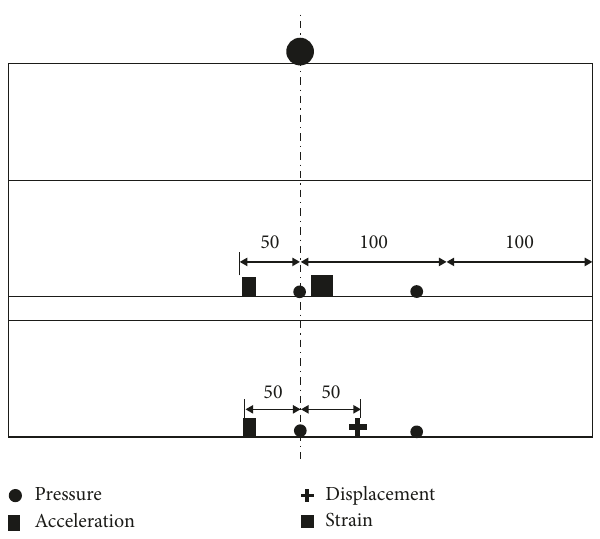
Figure 9: Arrangement of the measurement points in Tests 2, 3, and 4.